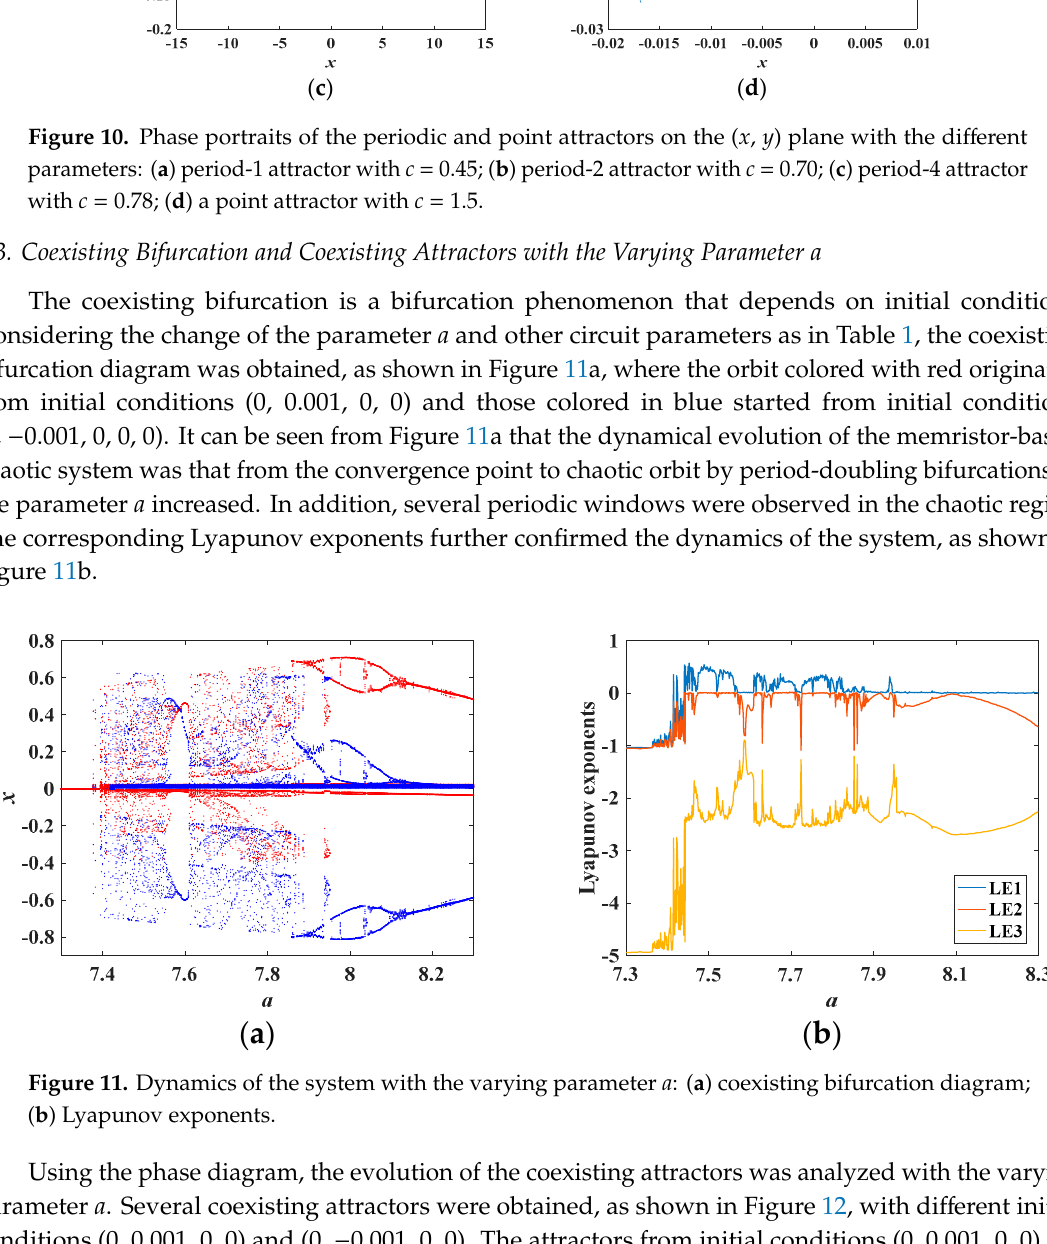
Figure 11. Dynamics of the system with the varying parameter a : ( a ) coexisting bifurcation diagram; ( b ) Lyapunov exponents.